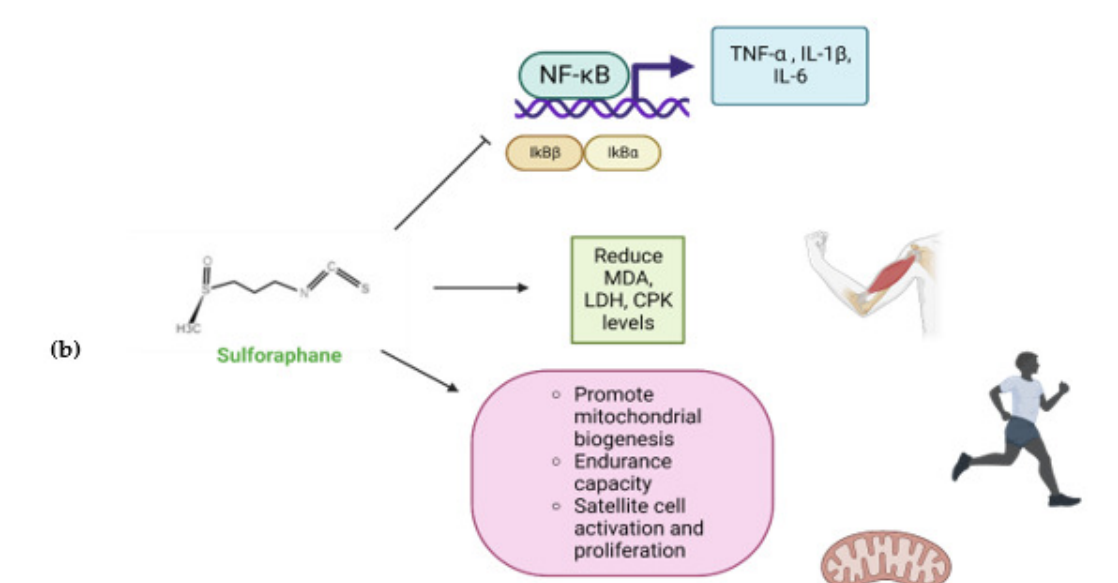
Figure 5. ( a ) Sulforaphane effects on Nrf2 signaling pathway. Sulforaphane promotes dissociation of Nrf2 from its negative regulator Keap1 leading to nuclear translocation and binding to the specific DNA sequence antioxidant response element (ARE) within small musculo-aponeurotic fibrosarcoma proteins (sMaf) inducing the antioxidant protein expression. ( b ) Effects of sulforaphane on skeletal muscle. Sulforaphane inhibits NF- κ B inflammatory signaling and reduces muscle oxidative damage biomarkers such malonaldehyde (MDA), lactate dehydrogenase (LDH), and creatin phospho-kinase (CPK). Sulforaphane is capable of promoting mitochondrial biogenesis, improving aerobic endurance capacity, and enhancing satellite cell activation and proliferation. Created with